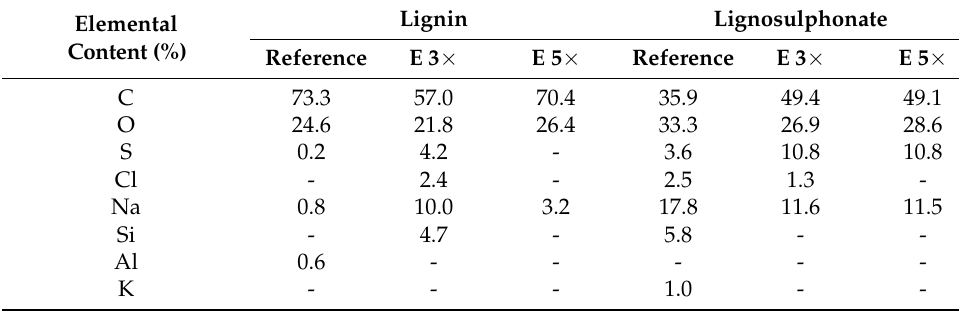
Table 6. Chemical constituent elements with FESEM EDX.